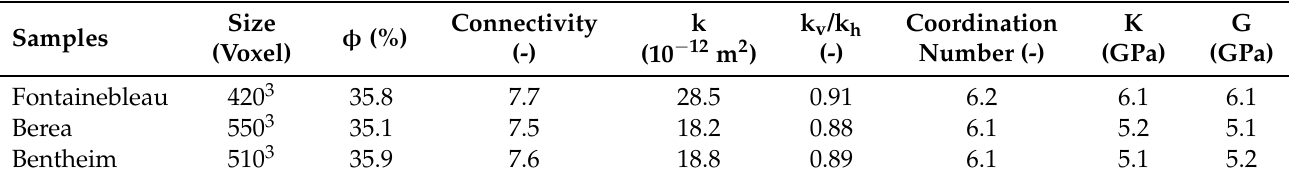
Granulometric, hydraulic and mechanical properties of the three unconsolidated synthetic sandstones (Fontainebleau, Berea and